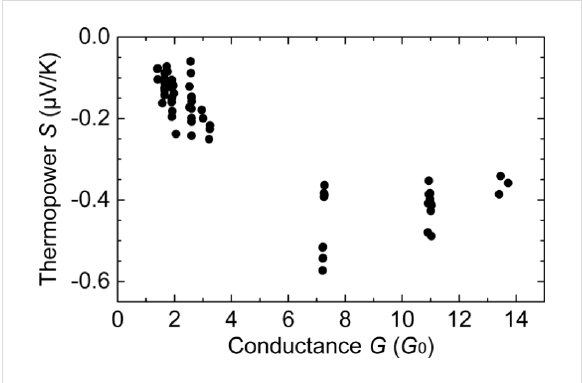
Figure 8: Time-dependent simulation of the resistivity of the two sensor leads due to heating. After 4 ms the resistance change amounts to ∆ R Sim = 0.23 Ω .